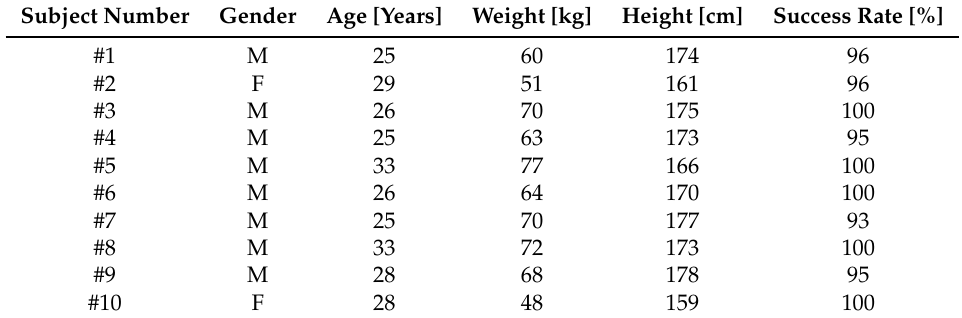
Table 2. Success rate of the gait recognition in the patient motion and posture monitoring